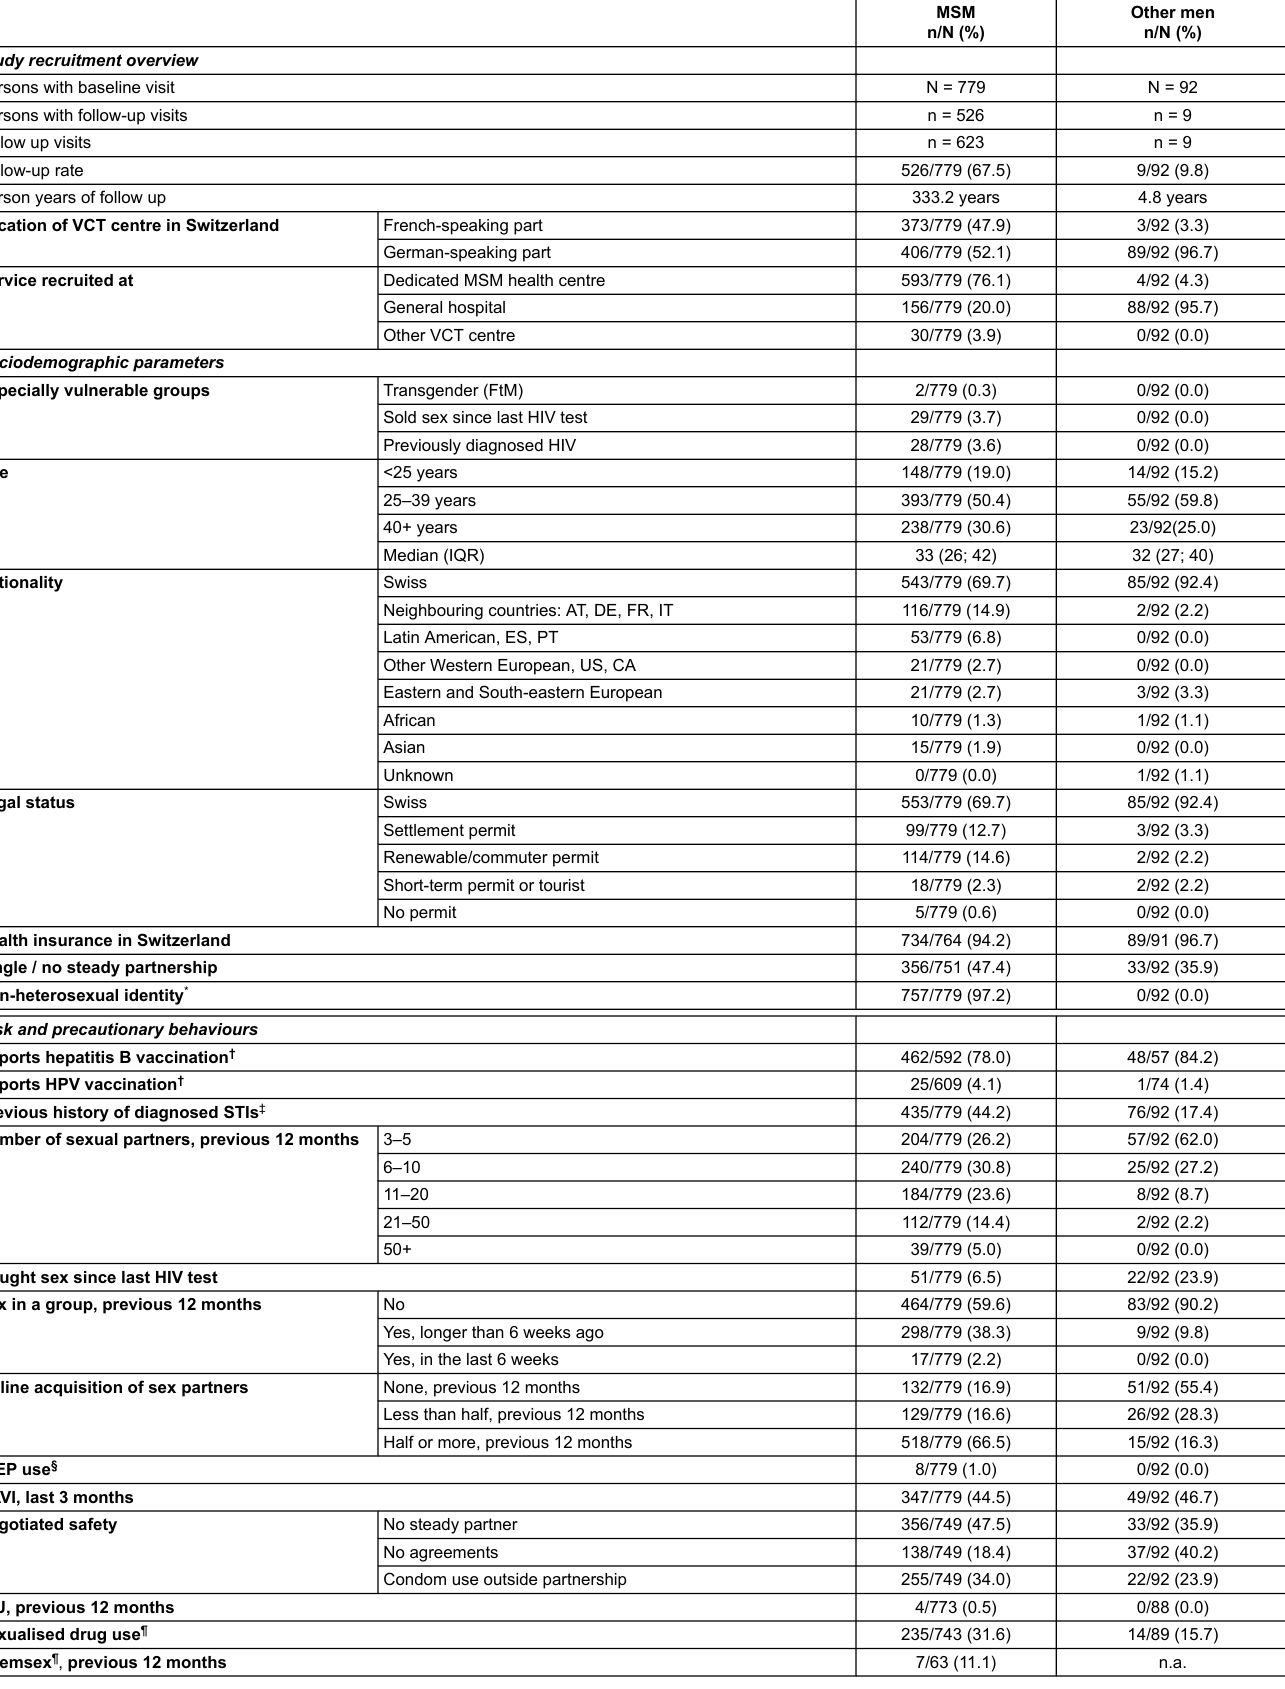
Table 1: Overview and sociodemographic parameters, risk and precautionary behaviours at baseline.